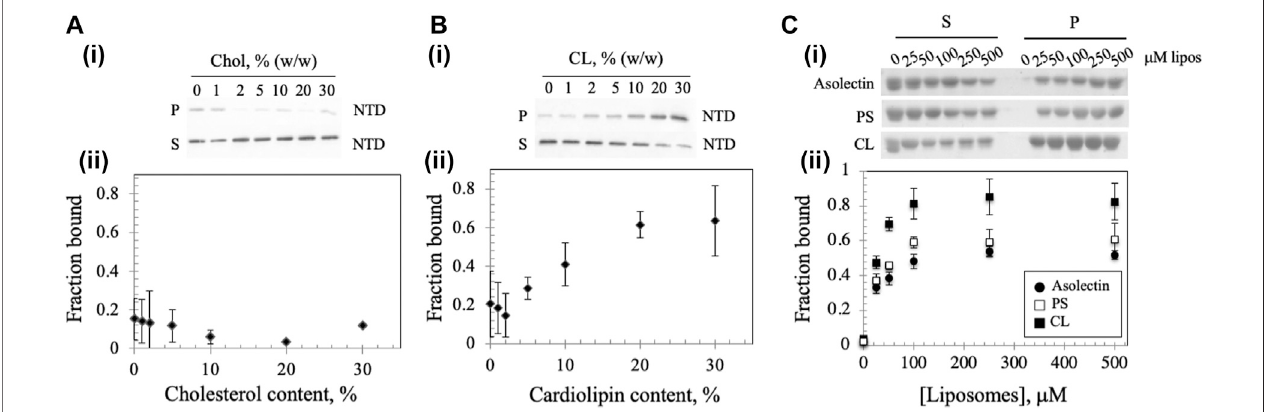
FIGURE 3 | Membrane composition affects Dm NTD liposome binding. Binding of Dm NTD to liposomes that contain (A) cholesterol or (B) CL as assessed by cosedimentationaredisplayedinarepresentativegelimage (i) andagraphoffractionbound (ii) .Calculationoffractionboundisdescribedinthe MaterialsandMethods . Each datapointrepresents themeanoftriplicatemeasurements. Theerrorbars indicate ± standarddeviation. (C) LiposomescontainingCLandnotPSshowenhanced Dm NTDbindingbycosedimentation.Varyingconcentrationsof15%CL-asolectinliposomes,30%PS-asolectinliposomesorasolectinliposomeswereincubated with10 μ M Dm NTDandseparatedbyultracentrifugation.Thefractionboundwascalculatedandplotted.Eachpointrepresentstheaverageandstandarderrorofthree different experiments.